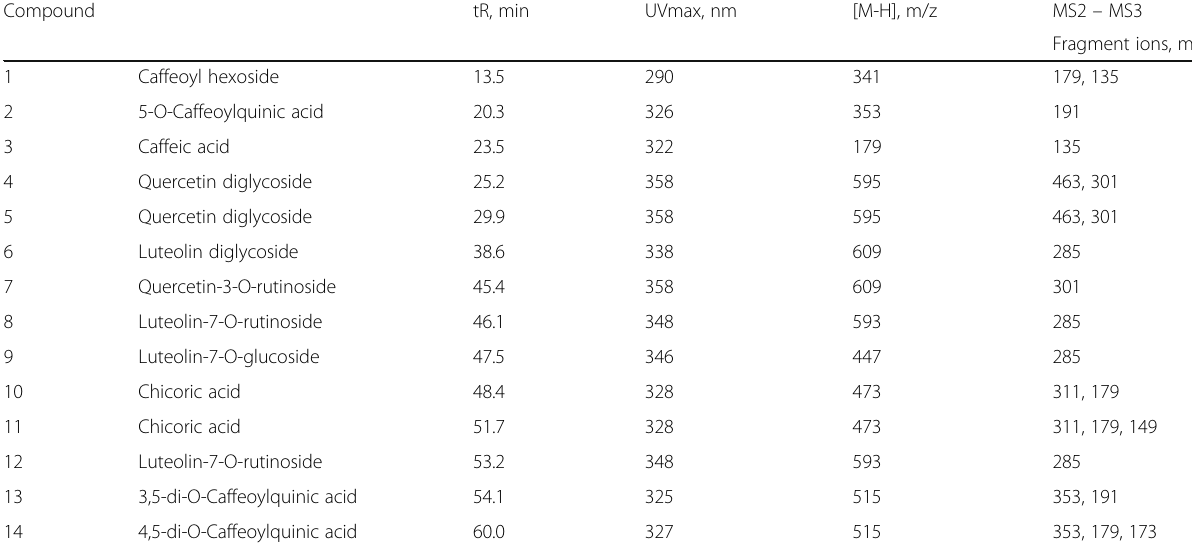
Table 4 Compounds identified in T. officinale fraction 9 by HPLC-PDA-ESI-MS/MS